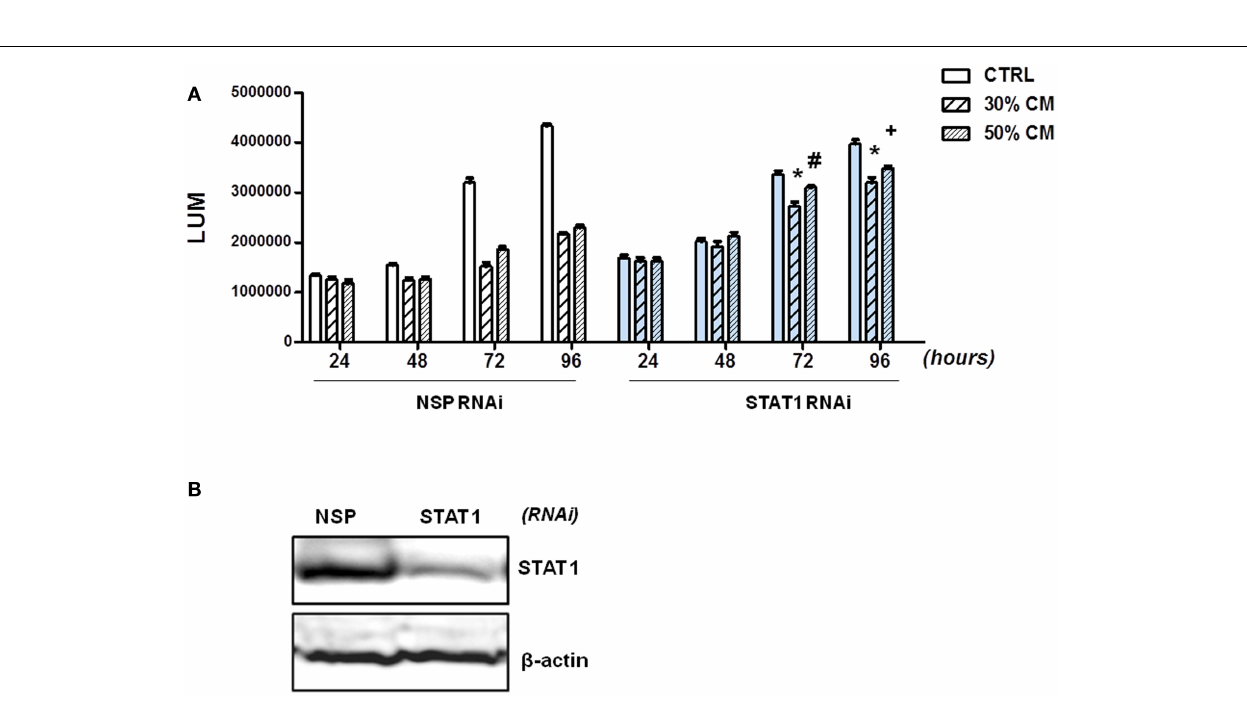
medium (CM) from 18Co cells by CellTiter-GLO Assay ( Promega ) at 24, 48, 72, and 96h as indicated. (B) Silencing of STAT1 in HCT116 cells was confirmed by immunoblotting. * p < 0.0001, # p = 0.03, + p = 0.0001, compared to cells transfected with NSP